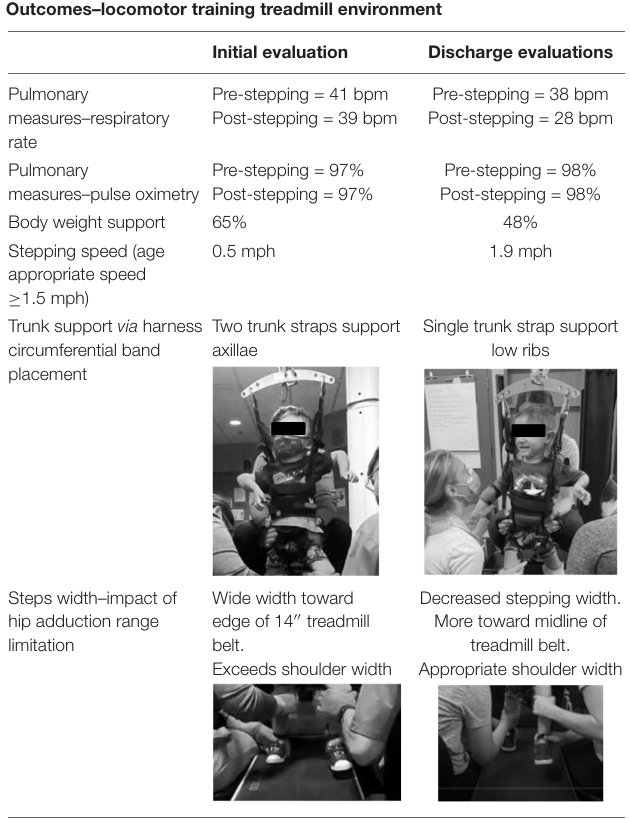
TABLE 1 | Outcomes in locomotor training treadmill